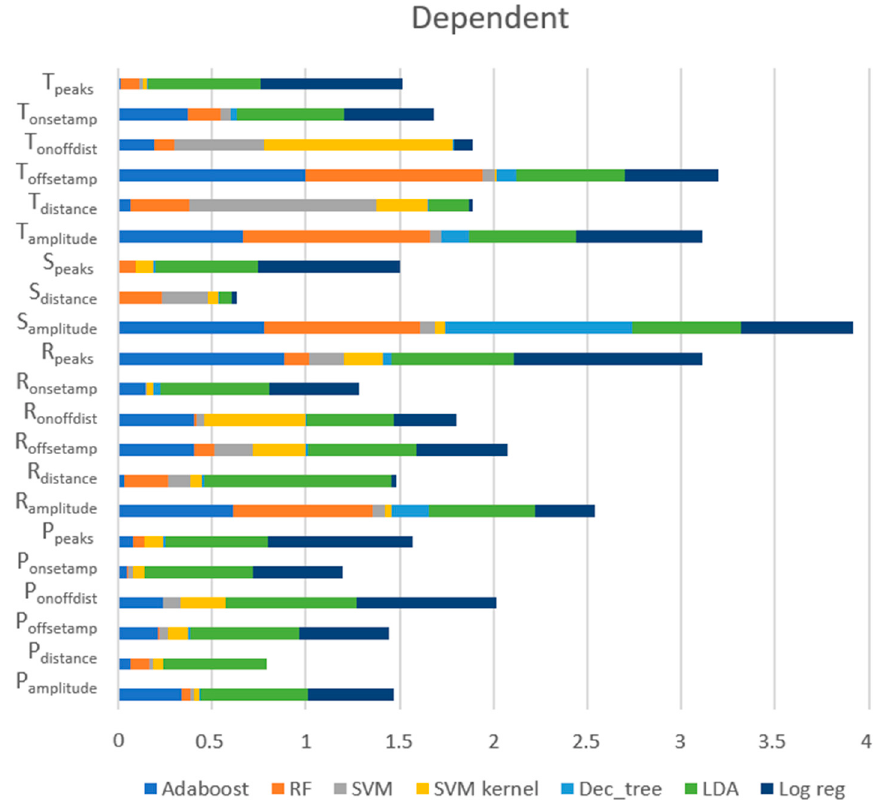
Figure 11. Importance of features for each model using the dependent approach.